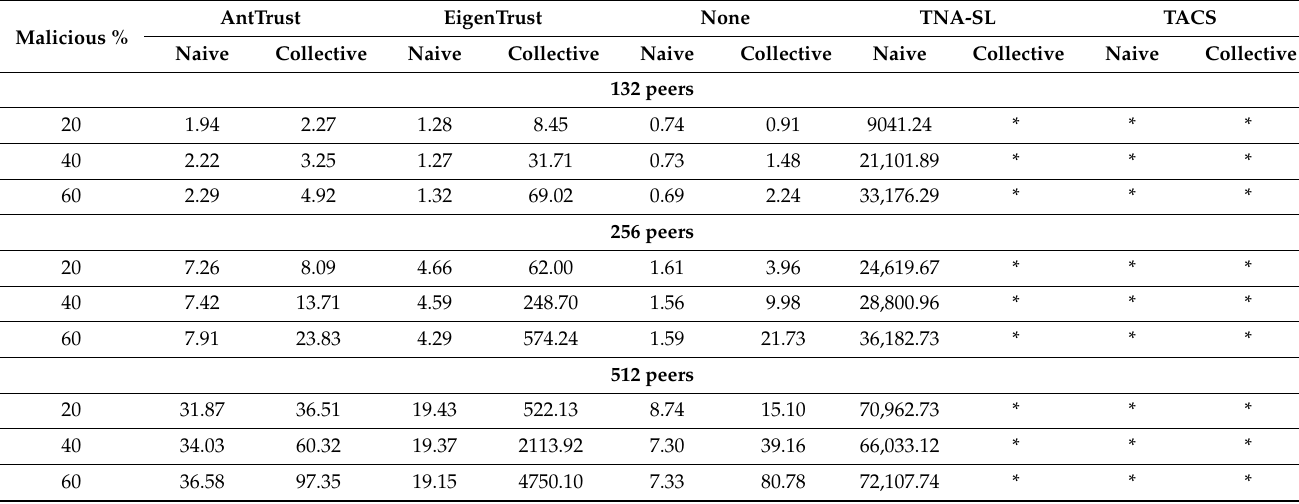
Table 5. Running time for 5000